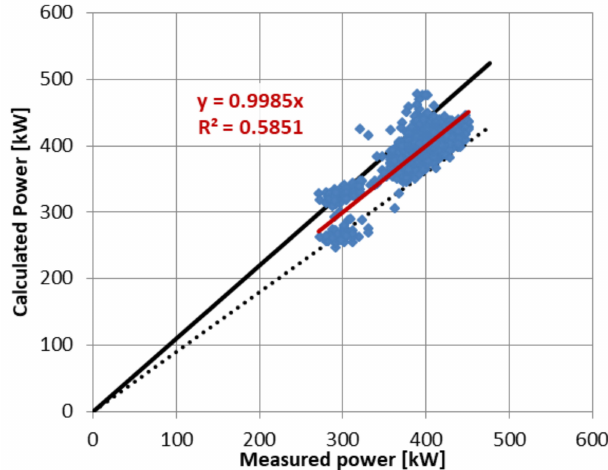
Figure 12. Result of model calibration with dataset CT2-Cal1, measured vs. calculated thermal power of cooling tower (2.4% outside +/ − 10% boundary); black solid/dotted lines show +/ − 10% boundaries.